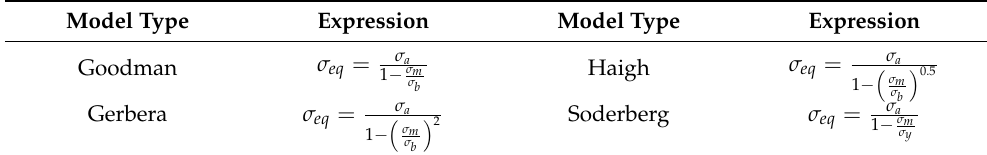
Table 6. The expressions of the commonly used mean stress